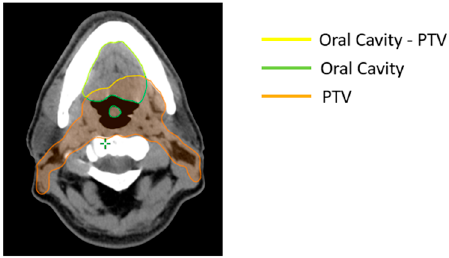
Figure 1. Boolean structure: oral cavity minus region overlapping with the planning target volume (PTV).